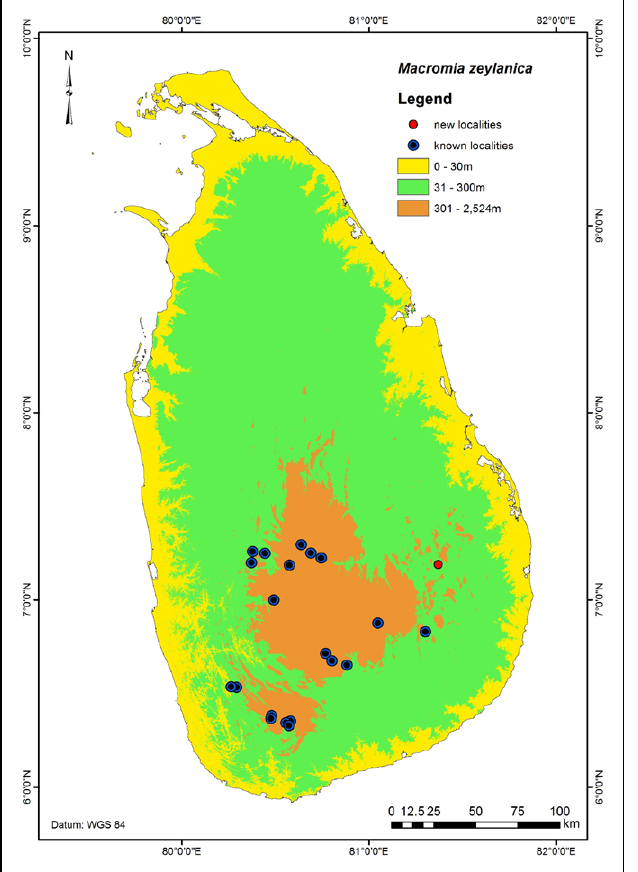
Figure 12. Distribution of Macromia zeylanica with new localities.